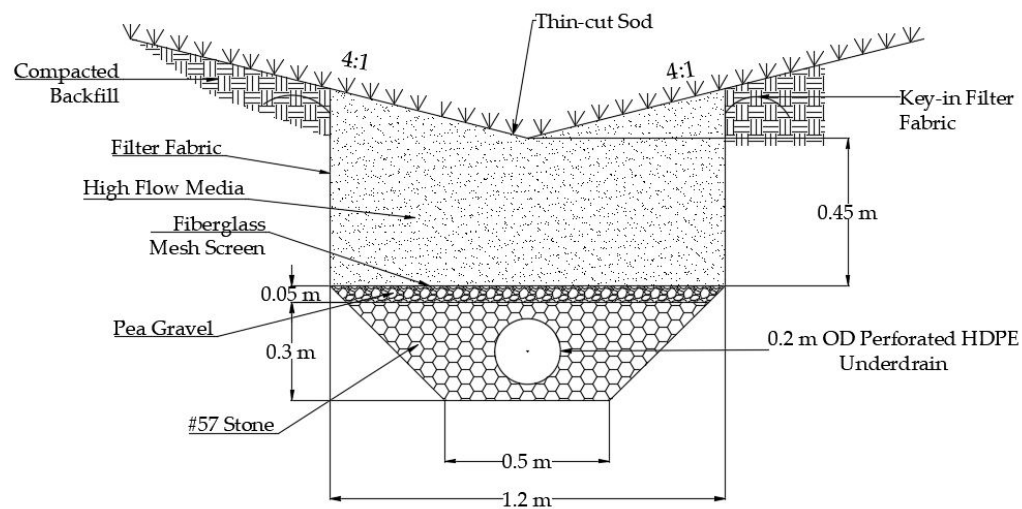
Figure 2. Horizontal cross-section of the underdrained portion (flow going into page). Note-not to scale.